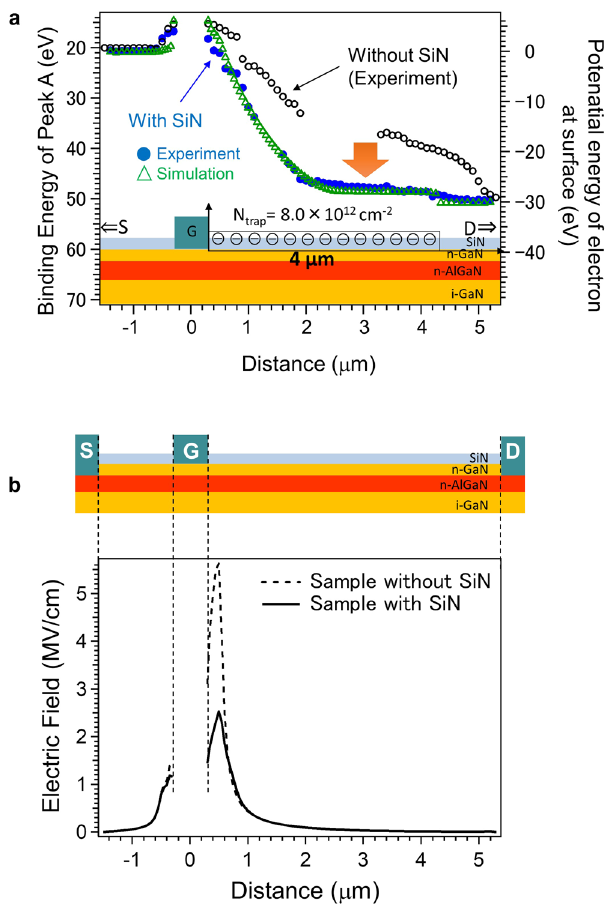
Figure 4. Operando photoelectron nanospectroscopy results utilized to clarify effect of SiN passivation. ( a) Line profile of the binding energy of the main Ga–N peak of the GaN-HEMT with SiN surface passivation under application of drain (30 V) and gate ( − 5 V) biases. ( b ) Estimated local electric field distribution with (thick line) and without (dotted line) SiN surface